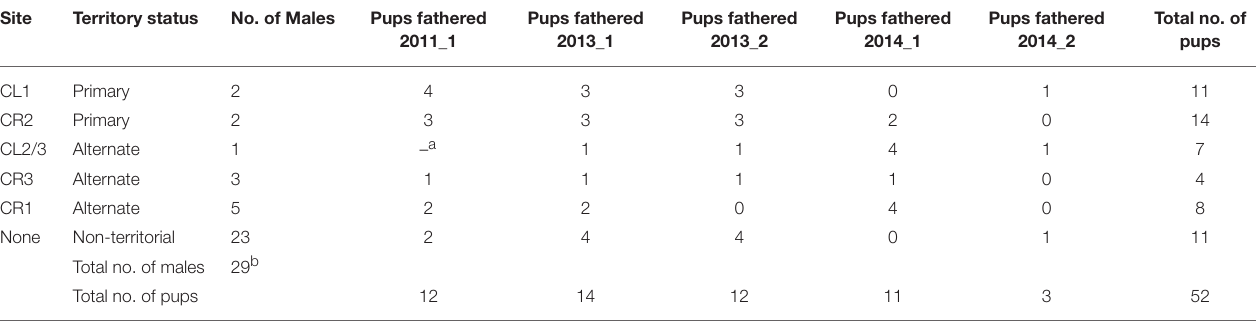
TABLE 5 | Paternity distribution of pups in Cabina 5 Left (CL) and Cabina 5 Right (CR) by cohort year.